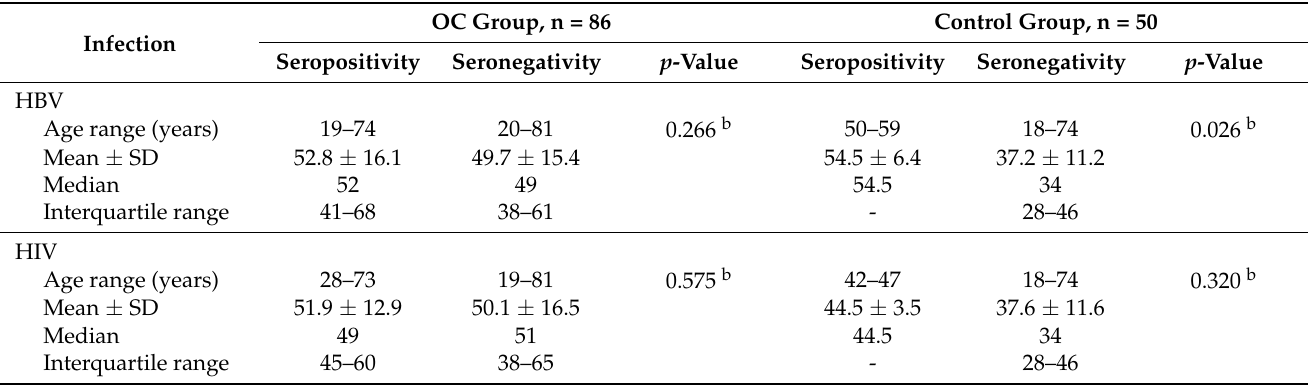
Table 2. Association of HBV, HCV, HIV, and HBV/HIV serological status of the participants with